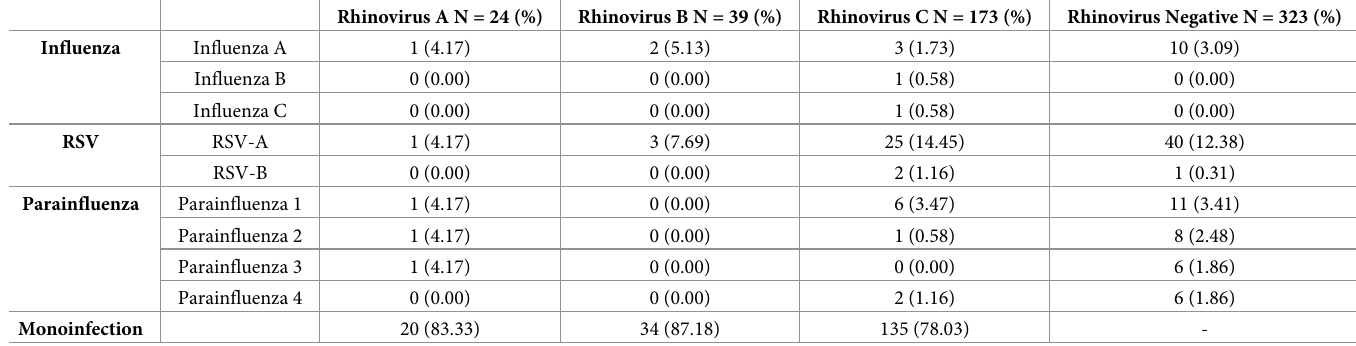
Table 3. Co-infections between rhinovirus and other respiratory